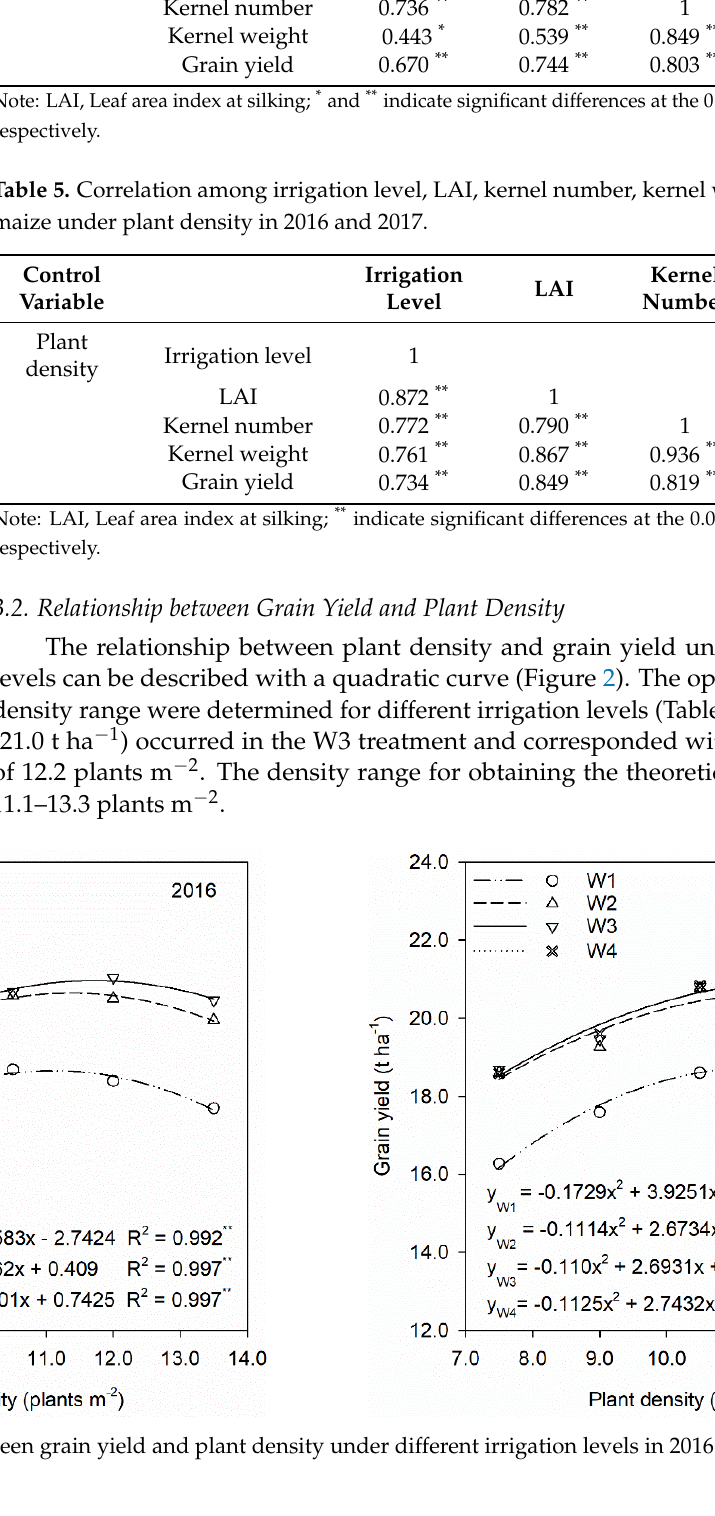
Table 4. Correlation among plant density, LAI, kernel number, kernel weight, and grain yield of maize under irrigation level in 2016 and 2017.